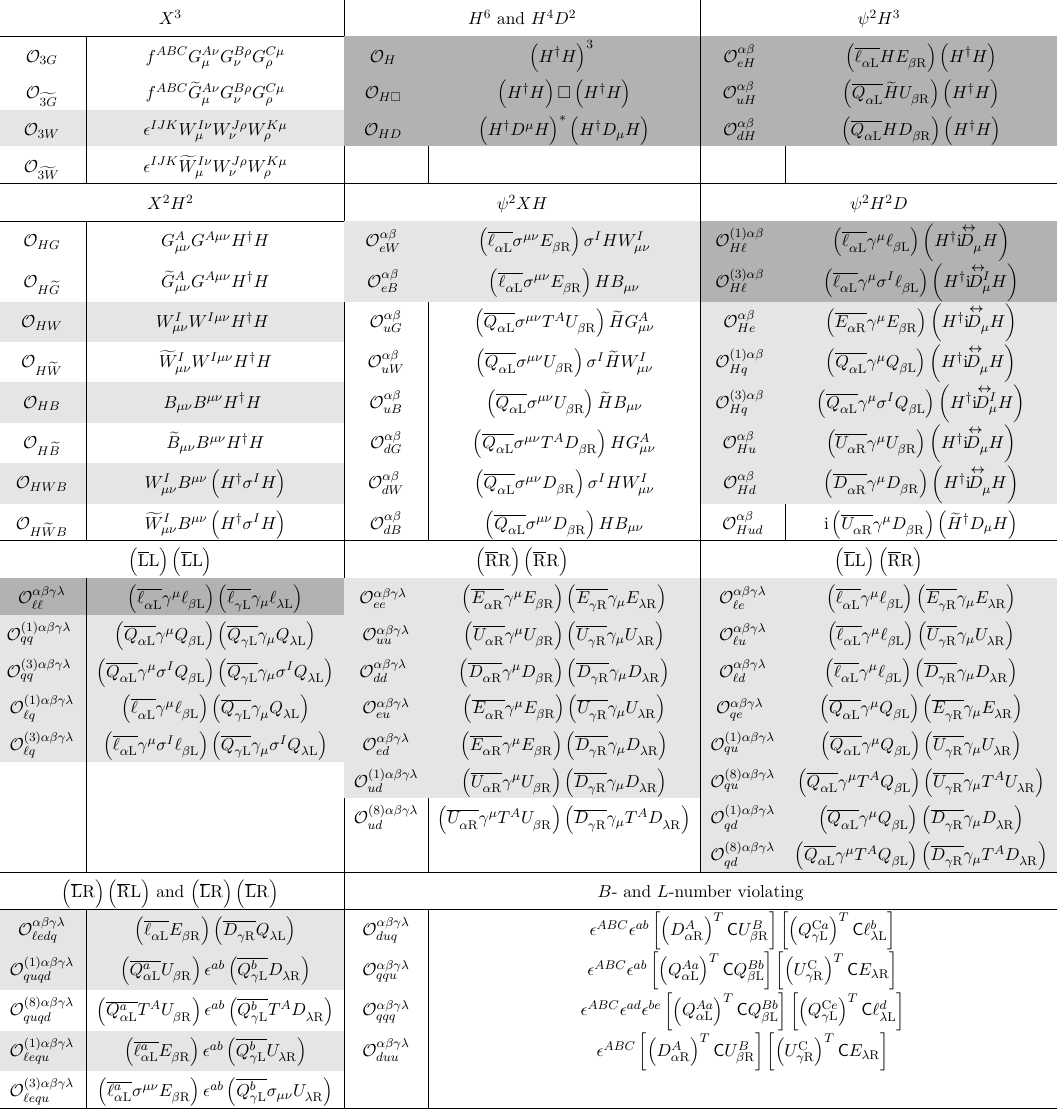
Table 1 . The dimension-six operators in the Warsaw basis in the SMEFT. Among these operators, only the 41 operators in the gray region are contained in the type-(I+II) SEFT, as well in the type-II SEFT. Moreover, the Wilson coefficients of the 9 operators in the dark gray region acquire additional cross contributions from entangled effects of the right-handed neutrinos and the triplet Higgs in the type-(I+II) seesaw